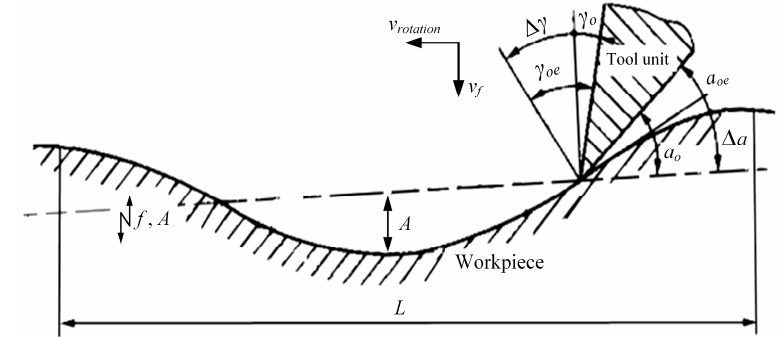
Figure 10. Schematic diagram of sinusoidal vibrating drilling.